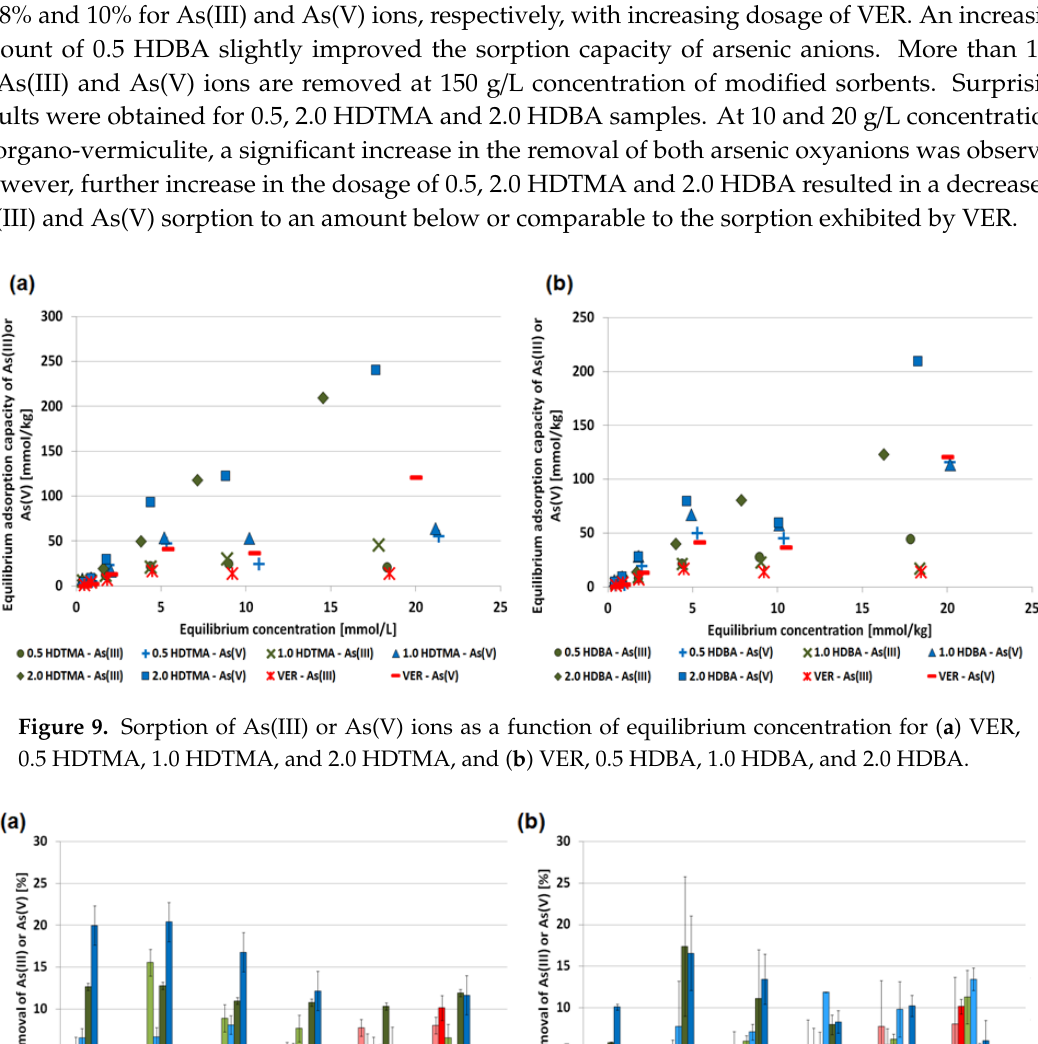
Figure 10. Sorption of As(III) or As(V) ions as a function of dosage sorbent for ( a ) VER, 0.5 HDTMA, and 2.0 HDTMA, and ( b ) VER, 0.5 HDBA, and 2.0 HDBA.